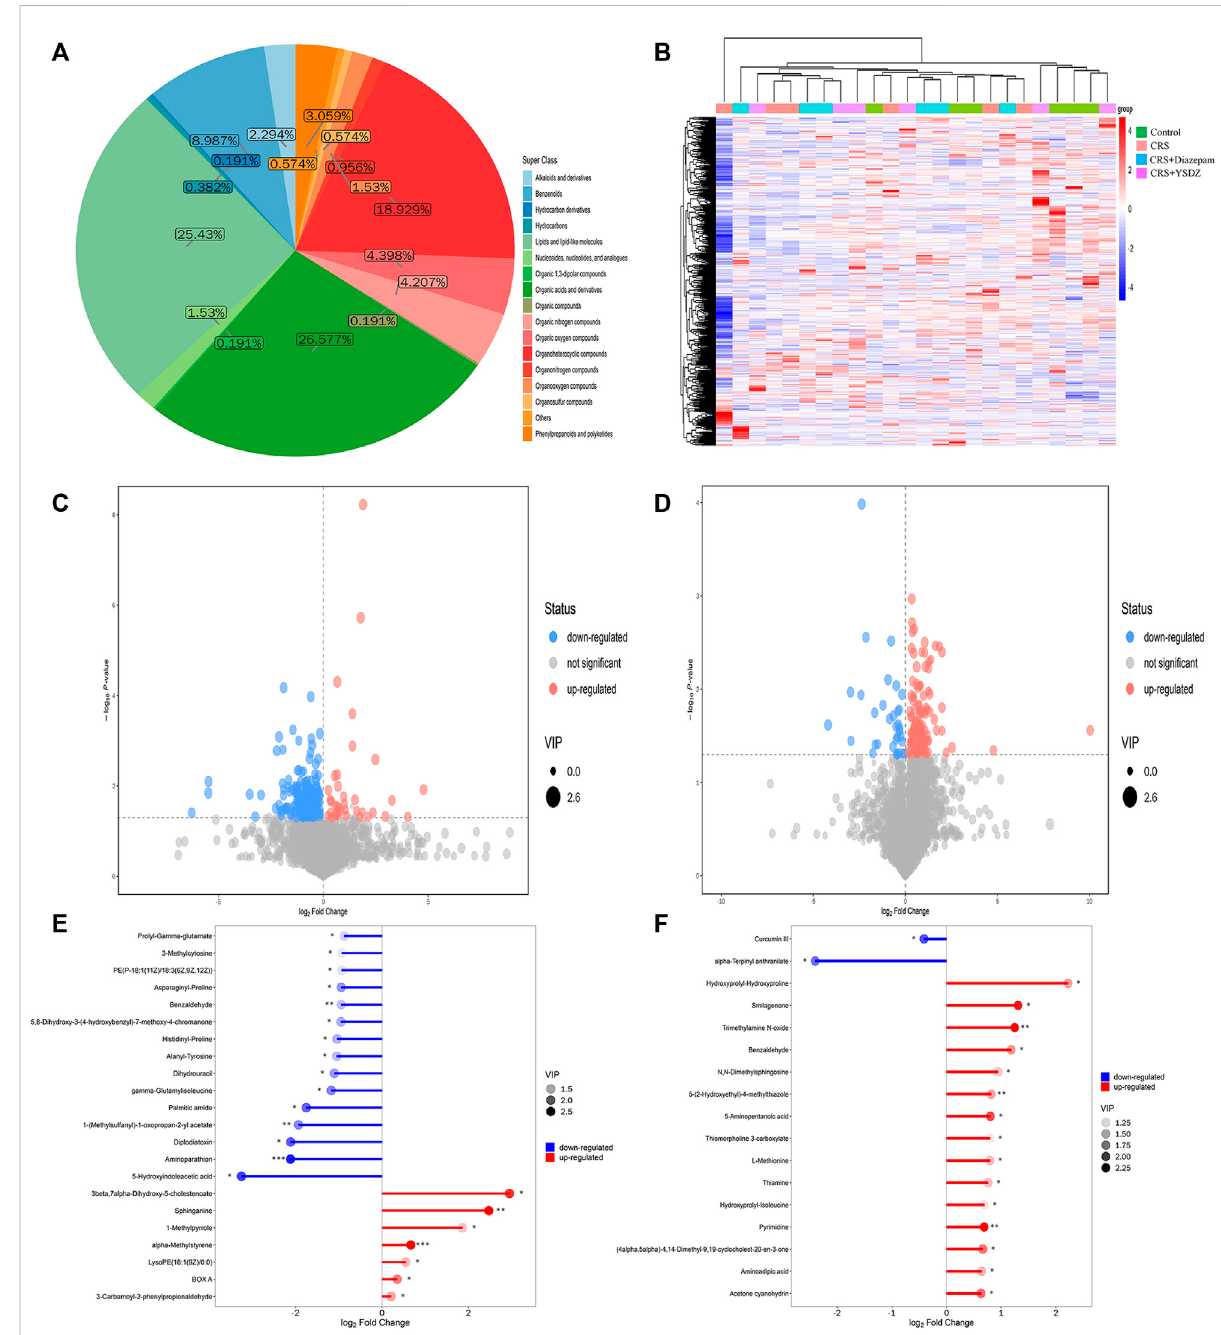
FIGURE 11 Metabolitecomprehensiveanalysis. (A) Pieplotofmetaboliteclassi fi cationandproportion. (B) Heatmapofhierarchicalclusteringanalysisforall groups. The abscissa in the fi gure represents different sample groups, the ordinate represents all metabolites, the color blocks at different positions represent the relative expression levels of the metabolites at the corresponding positions, red indicates high expression of the substance, and blue indicates low expression of the substance. (C,D) are Volcano plot. The X -axis represents multiple changes of all substances compared in this group (logarithmicbase 2),the Y -axis represents the p -value ofstudent ’ t test,and thesize of thescatter point represents VIPvalues oftheOPLS-DA model. Signi fi cantly upregulated metabolites are represented in red, while those signi fi cantly downregulated are represented in blue, unchanged metabolites are shown in gray. (C) is CRS vs. Control. (D) is CRS + YSDZ vs. CRS. (E,F) are Matchstick analysis. The fi rst 15 metabolites most up or downregulated are displayed. The X -axis shows change after logarithmic transformation, the color depth of the point represents the VIP value, and the Y -axis represents differential metabolites. (E) is CRS vs. Control. (F) is CRS + YSDZ vs.